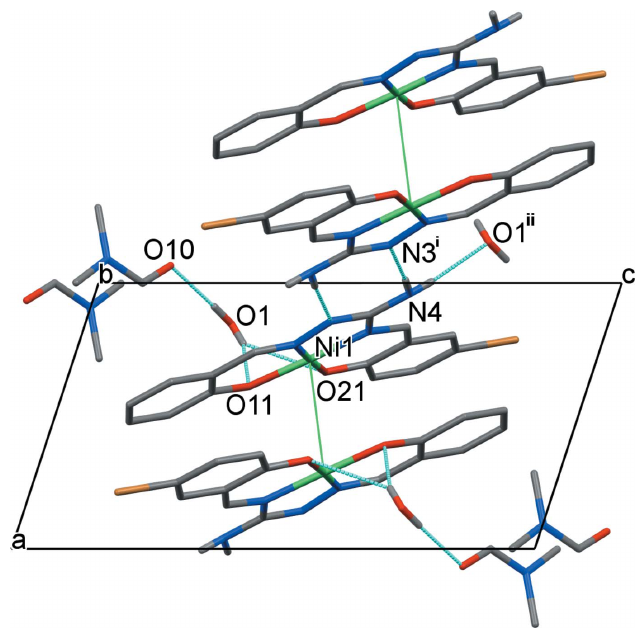
Figure 3 Fragment of the crystal packing of (I), viewed along the b -axis direction, showing intermolecular N—H (cid:2)(cid:2)(cid:2) N/O and O—H (cid:2)(cid:2)(cid:2) O interactions (CH hydrogen atoms were omitted for clarity; hydrogen bonds are shown as blue dashed lines; green lines joining Ni centres do not represent bonds). [Symmetry codes: (i) (cid:5) x + 2, (cid:5) y + 2, (cid:5) z + 1; (ii) (cid:5) x + 2, (cid:5) y + 1, (cid:5) z +